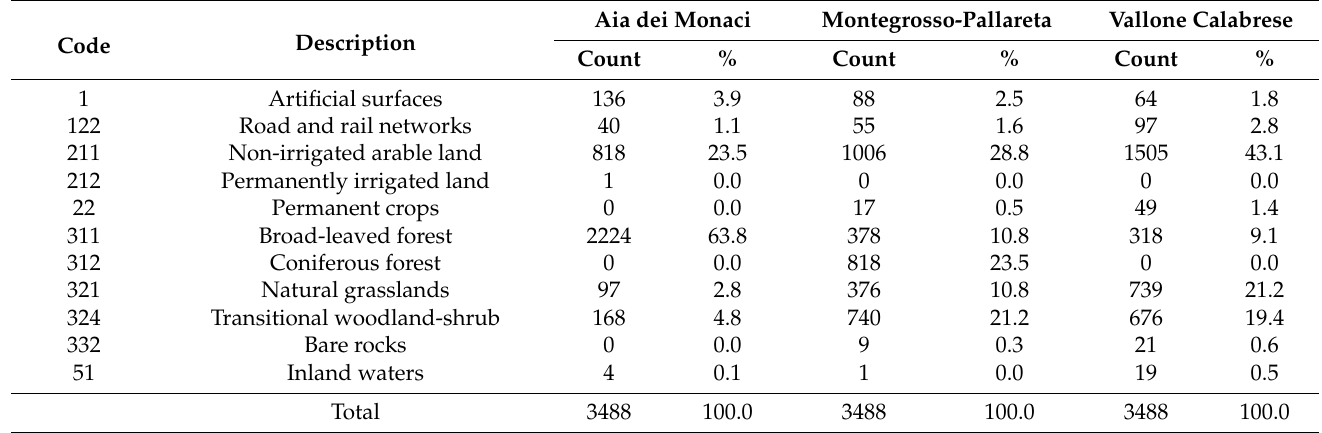
Table 1. Land use class distribution in the three study sites.